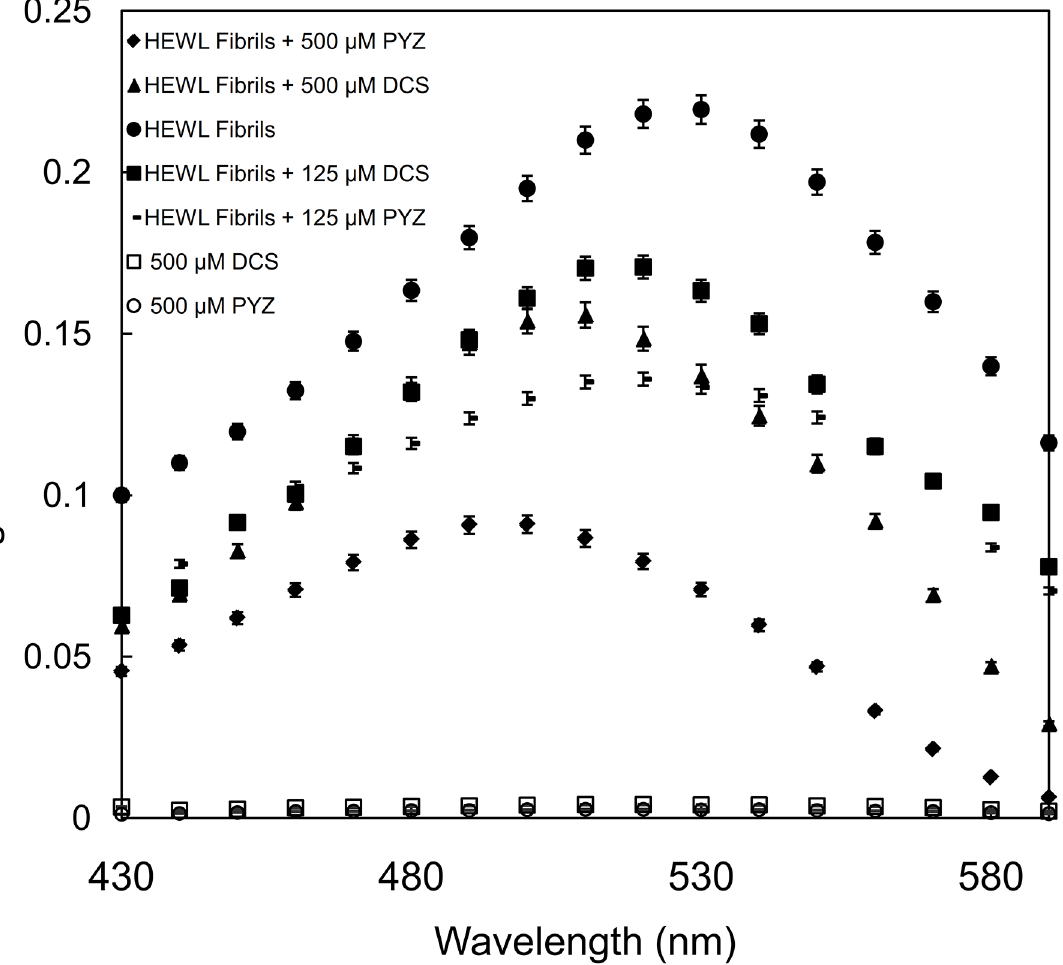
Fig 6. Congo red absorption spectrum of HEWL (10 μ M) incubated at 65°C over 120 h in absence and presence of 125 and 500 μ M each of PYZ and DCS.